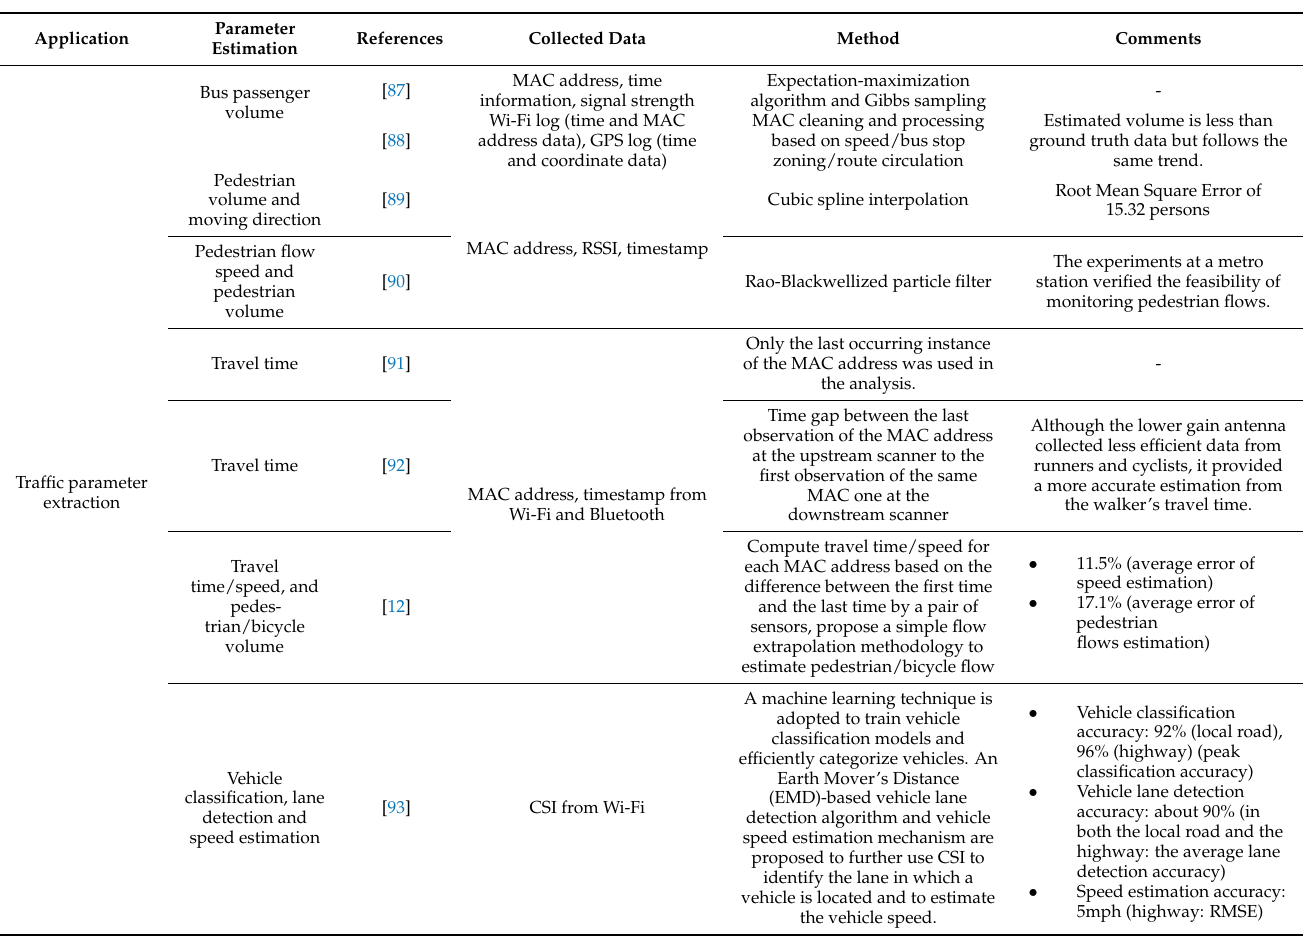
Table 3. Summary of Wi-Fi-involved technologies in traffic parameter extraction and travel mode